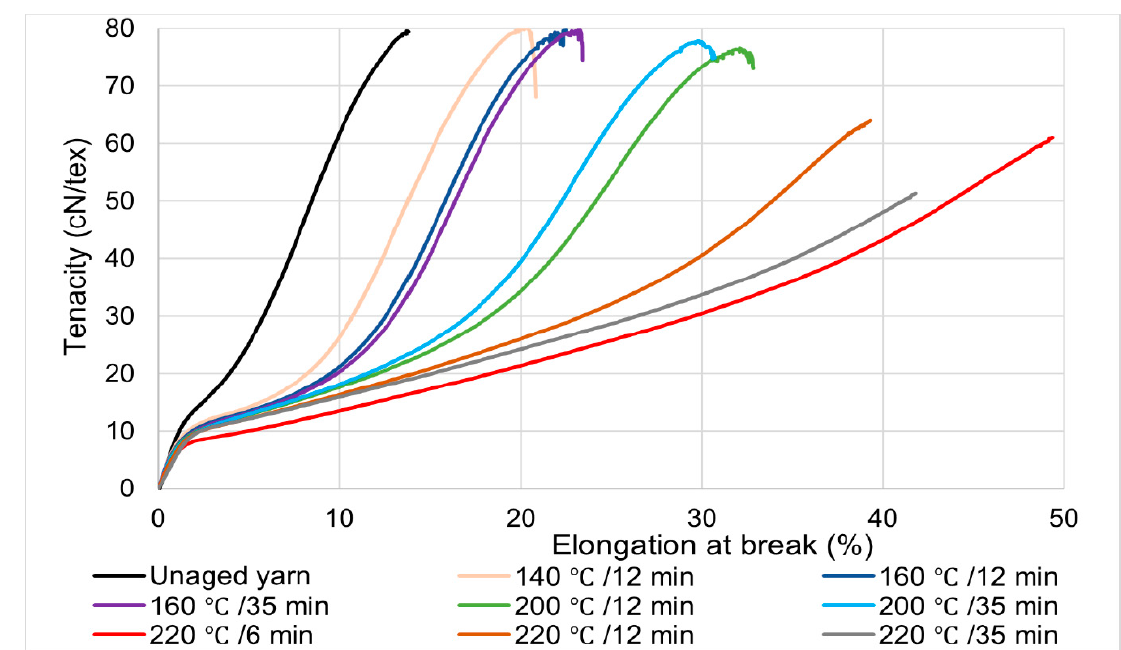
Figure 4. Comparison between stress–strain diagram of unaged and thermally aged 110 tex of high tenacity polyester